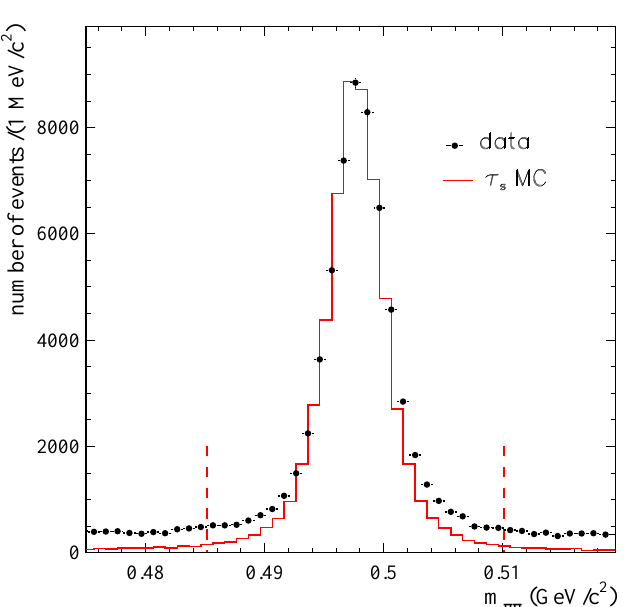
Figure 2: The π + π − mass spectrum for K and signal simulation (histogram). Between the two vertical lines there is a signal region used in the procedure of non- K